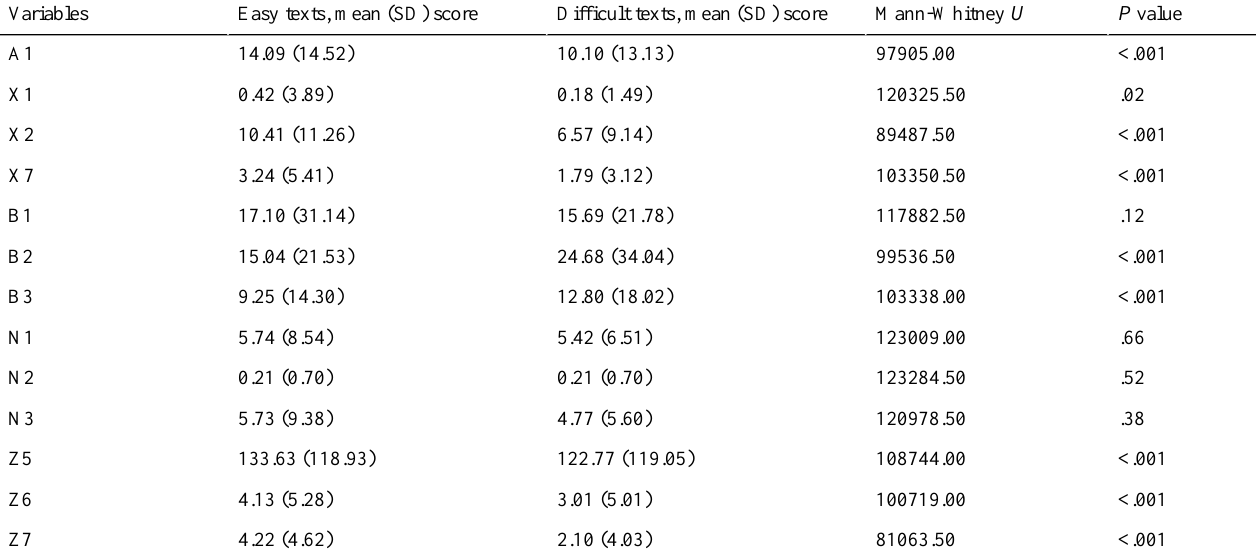
Table 2. Differences between easy and difficult medical texts derived by the Mann-Whitney U